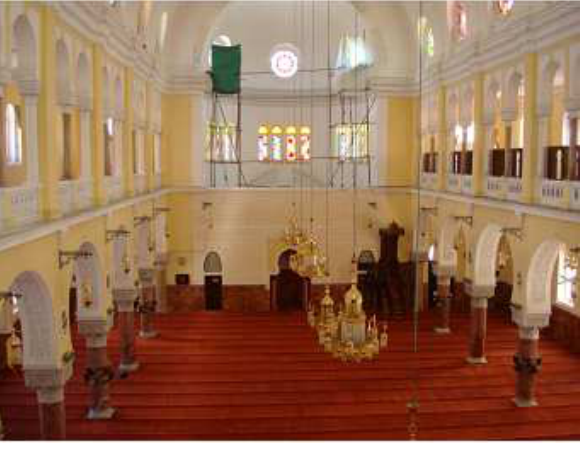
Figure 3. The interior of the mosque.